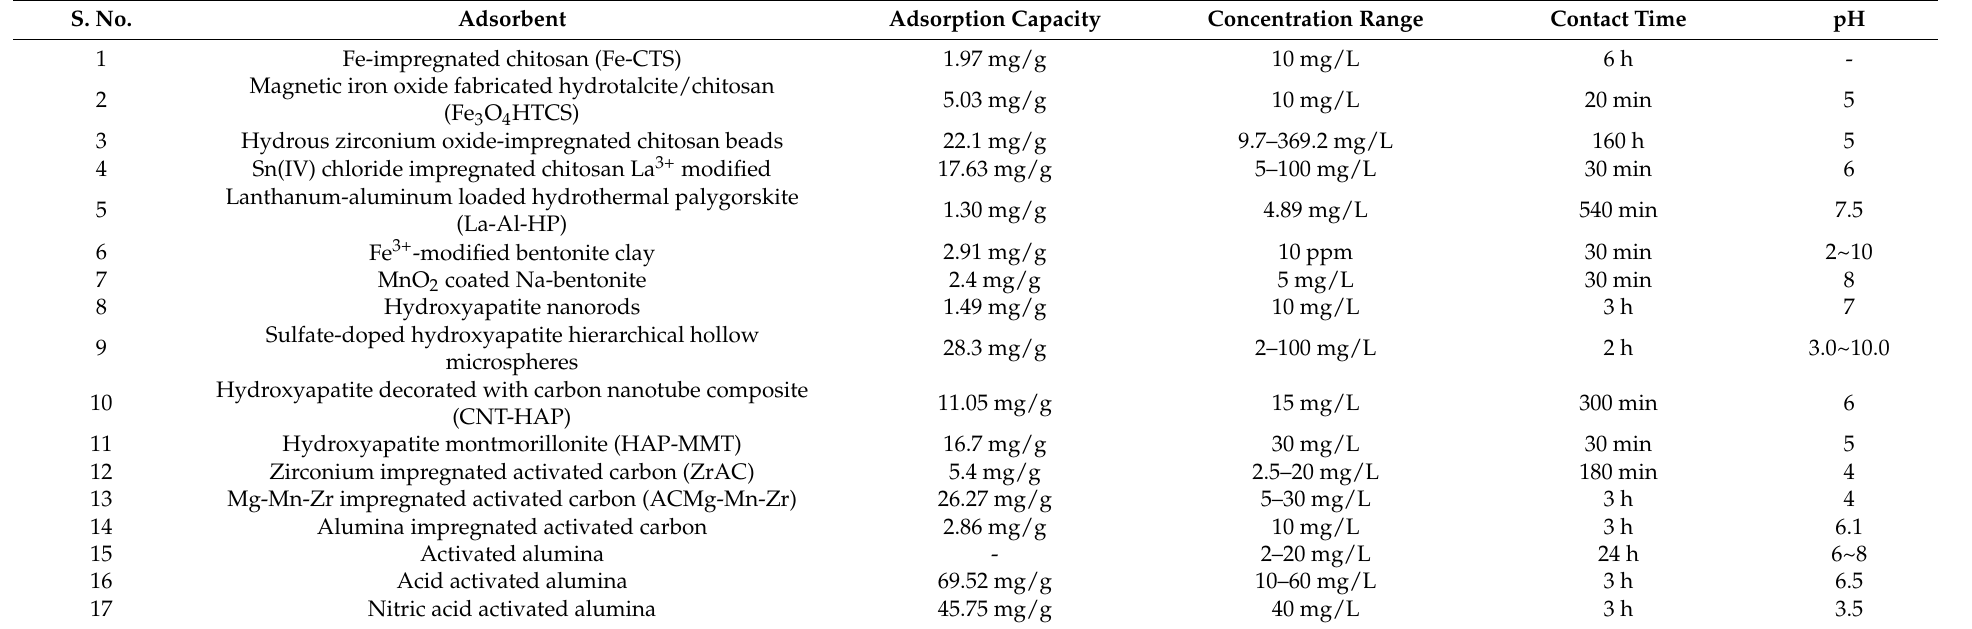
Table 2. A summary of various adsorbents for fluoride removal from